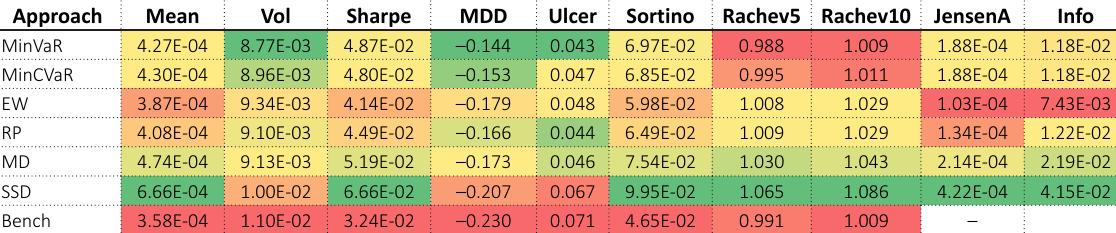
Table 4. Out-of-sample results using the minimum variance preselection